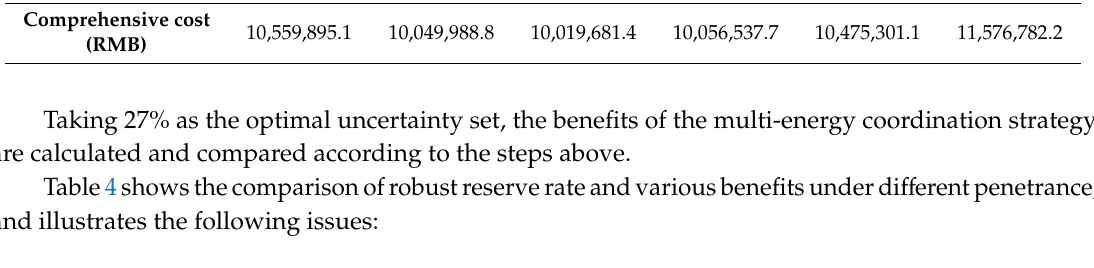
Table 4. Comparison of two penetrance robustness